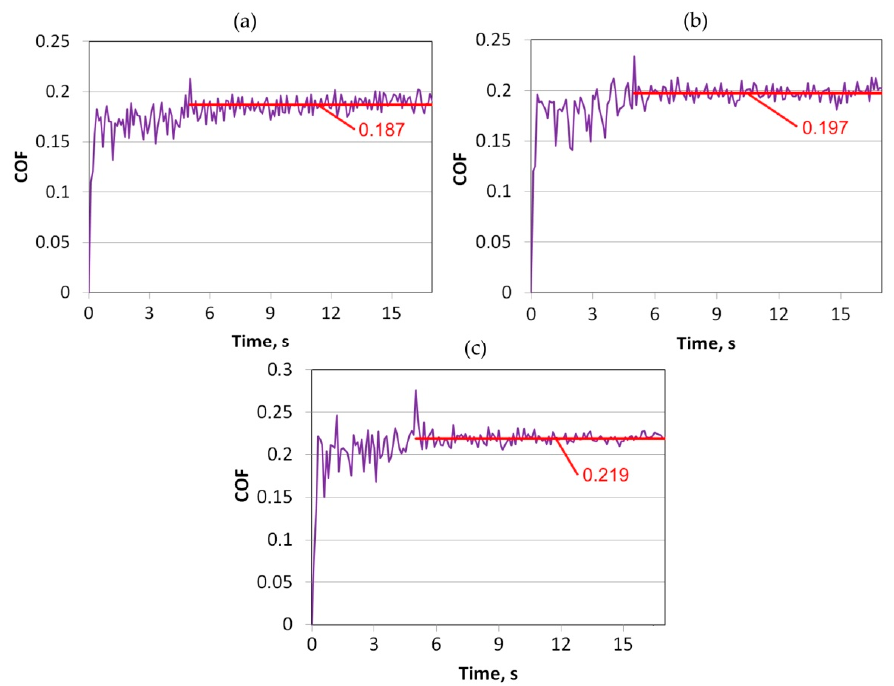
Figure 11. Numerically predicted variation of the COF for height of drawbead h = 18 mm and different specimen widths: ( a ) 20 mm, ( b ) 14 mm and ( c ) 7 mm.